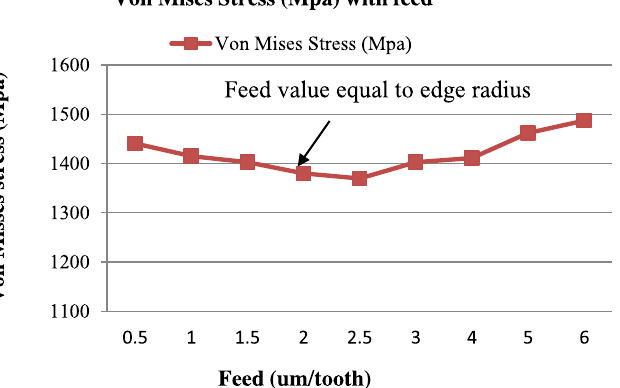
Fig. 5. Variation of maximum Von-Mises stress with feed.